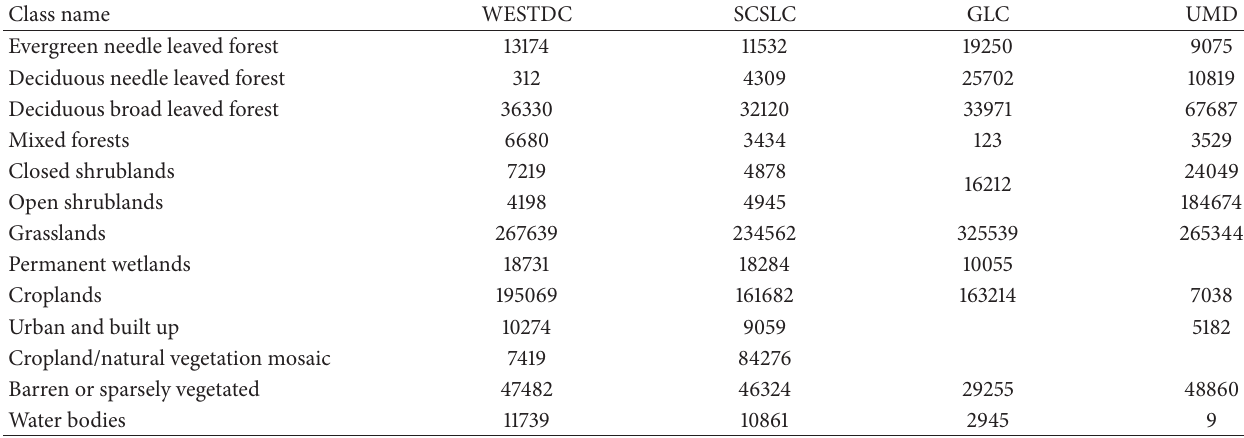
Table 4: Comparison of different classification among the IGBPDIS, SCSLC, WESTDC, and UMD products (unit km 2 ).